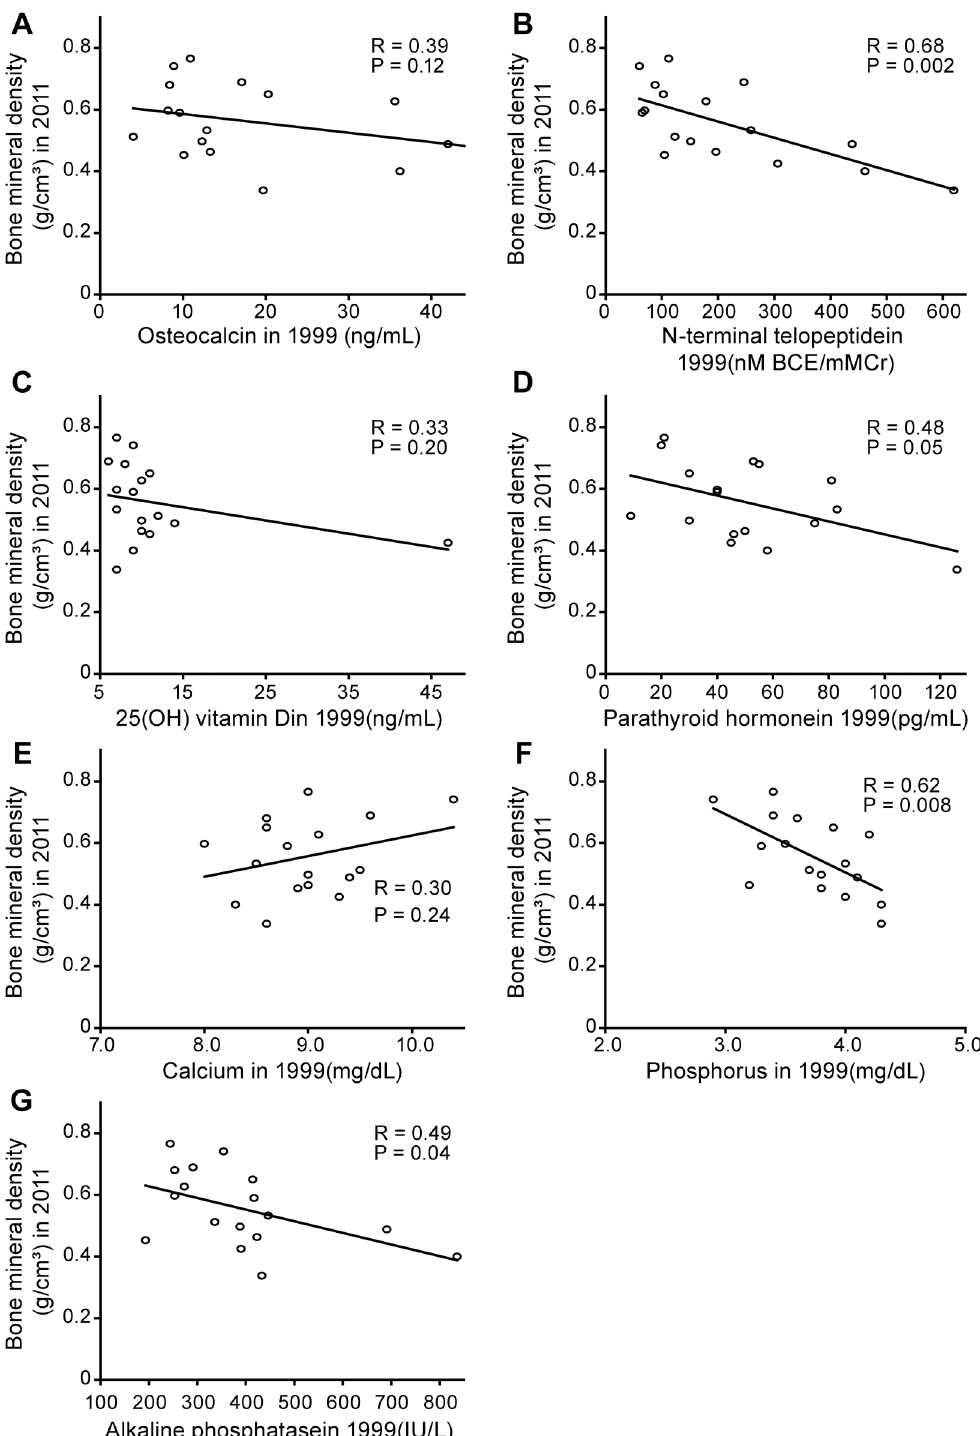
Fig 3. Association between the bone metabolism marker levels at baseline with the bone mineral density during a follow-up of 12 years in patients whose baseline age was < 30 years.